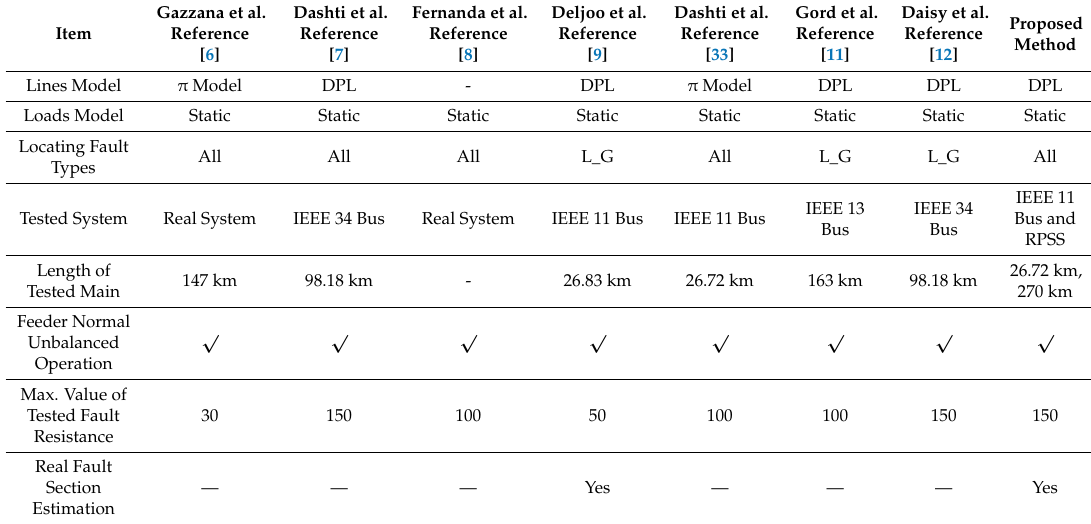
Table 5. Comparing the proposed method and some fault location